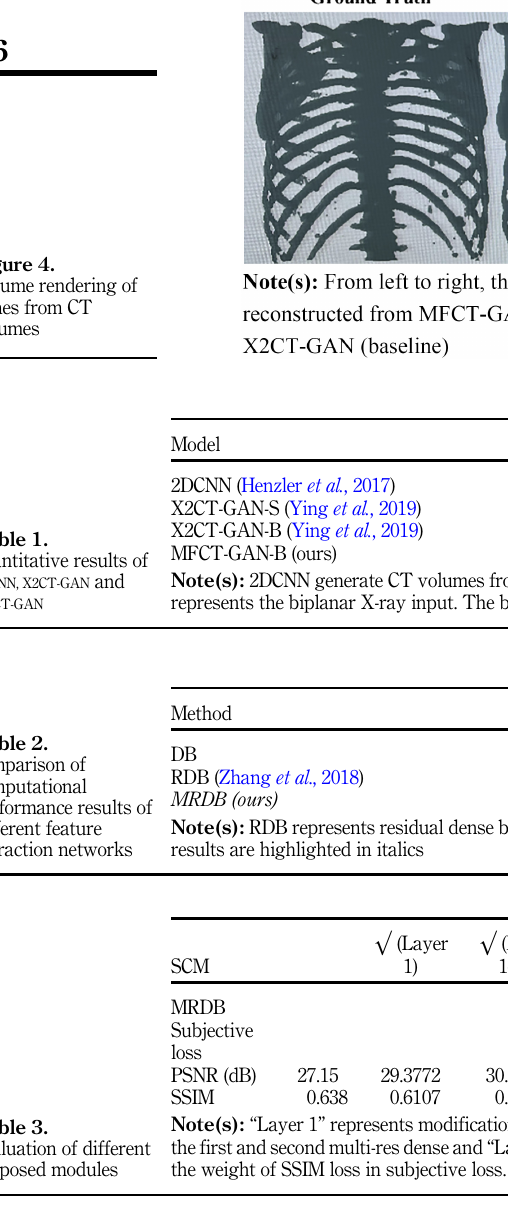
Figure 4. From left to right, this is the reconstruction effect, including ground truth, X2CT-